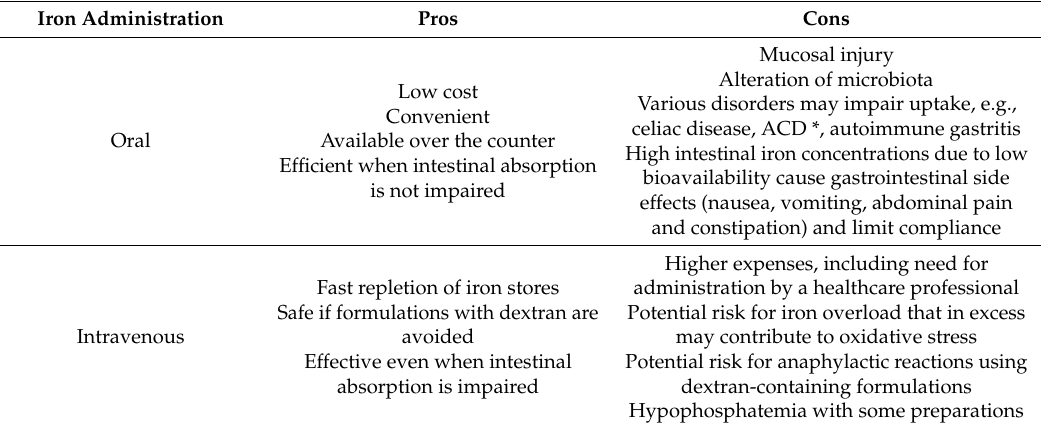
Table 1. Main principles of iron supplementation and their pros and